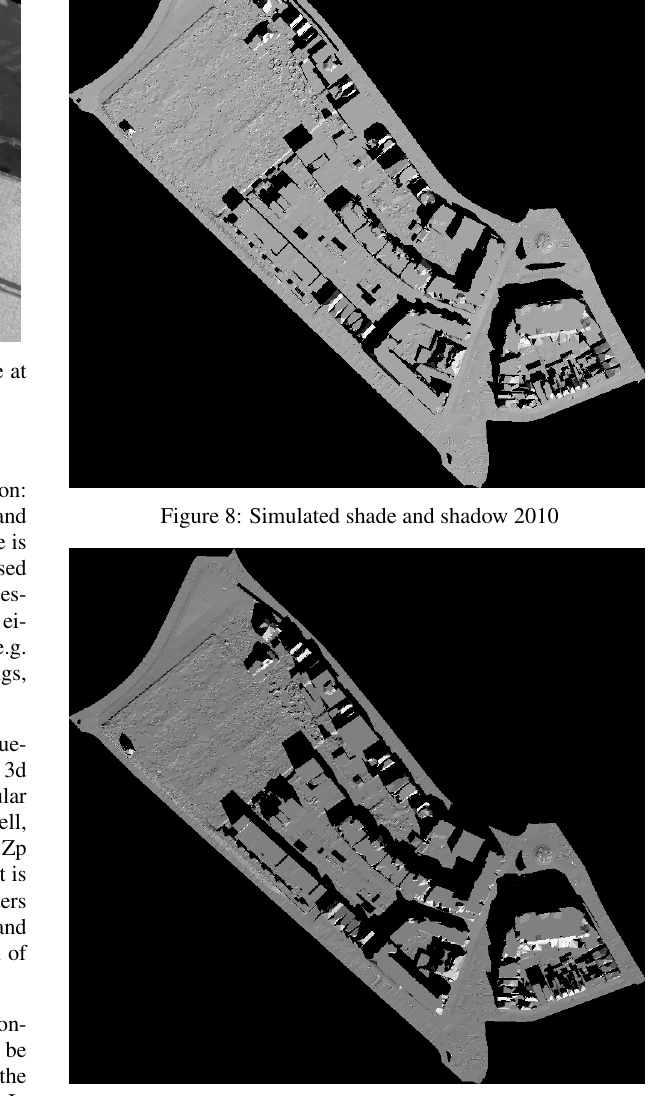
Figure 9: Simulated shade and shadow image